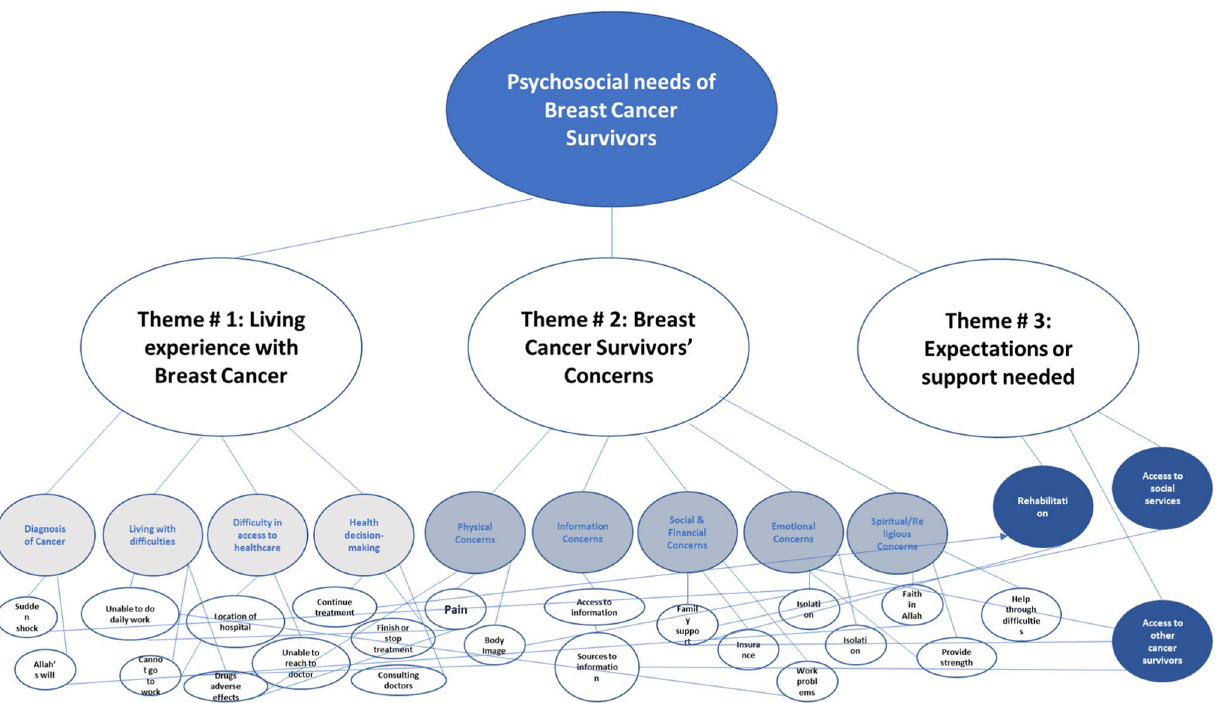
Fig. 1 Thematic map—psychosocial needs of breast cancer